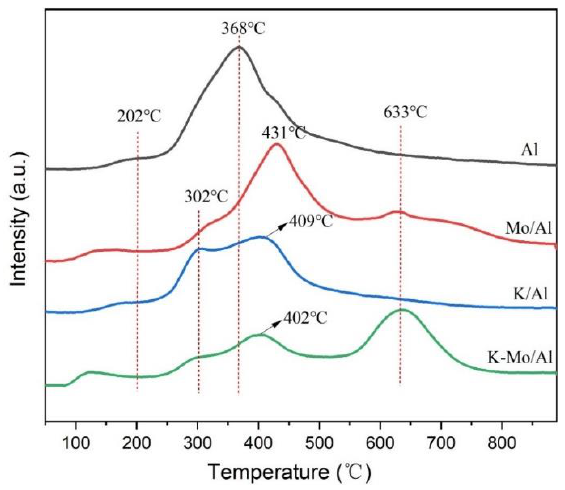
Figure 5. H 2 -TPR spectra of the fresh